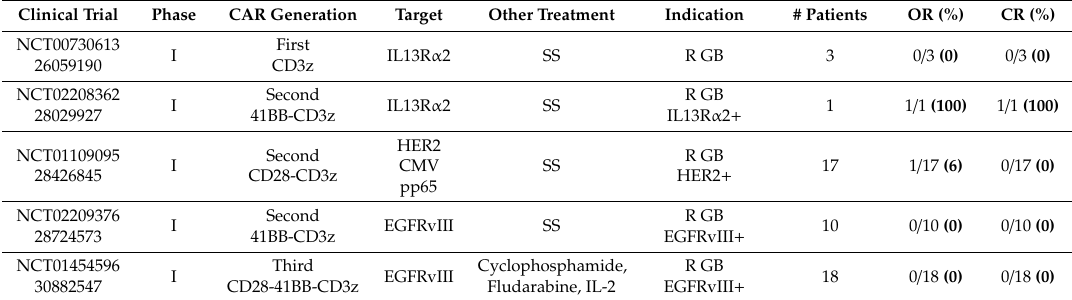
Table 4. Phase I clinical trials with gene-engineered T cells in glioblastoma.